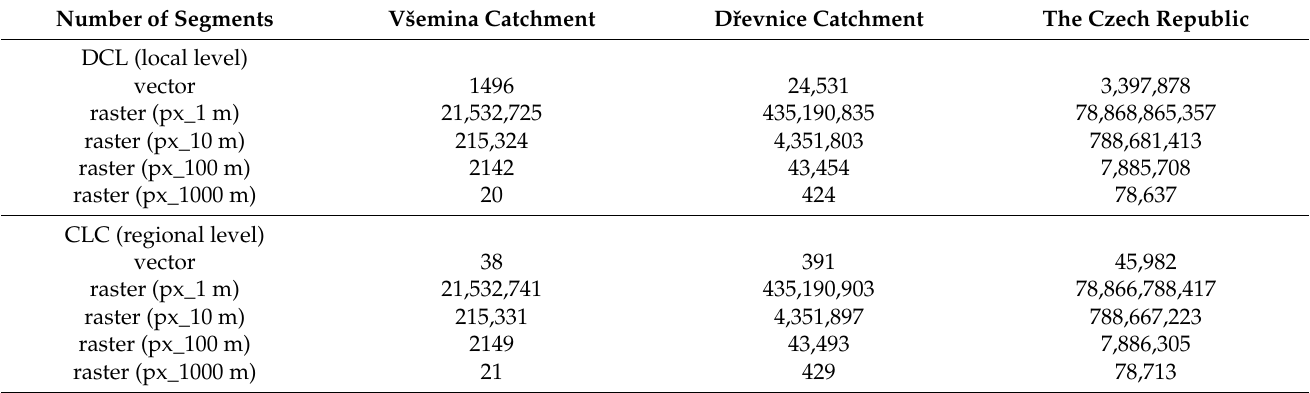
Table 5. Number of segments in individual landscape matrices on the basis of vector and raster data for all studied